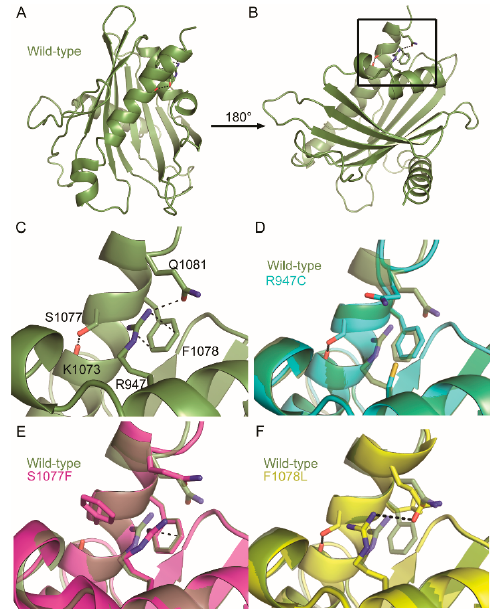
Figure 5. Consequences of COSMIC missense mutations on the tertiary structure of the DLC-1 START domain. ( A – C ) Conserved residues colocalizing near the C-terminal helix form multiple tertiary-level interactions in the wildtype DLC-1 START domain (green). ( D ) R947C disrupts the cation– π interaction of F1078 and hydrogen bond of Q1081. ( E ) F1078L disrupts the R947 cation– π interaction but retains the hydrogen bond between R947 and Q1081. ( F ) S1077F retains the cation– π interaction and disrupts all other bonds. Dotted lines indicate hydrogen bonding and cation– π interactions. Structures carrying the R947C, F1078L, and S1077F mutations are blue, pink, and yellow, respectively. ( C – F ) are zoom-ins of black box in ( B